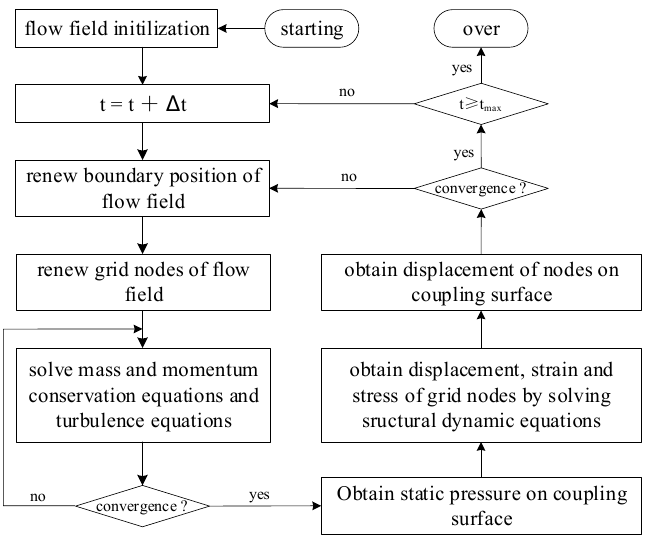
Figure 1. Flow chart of bidirectional FSI simulation.